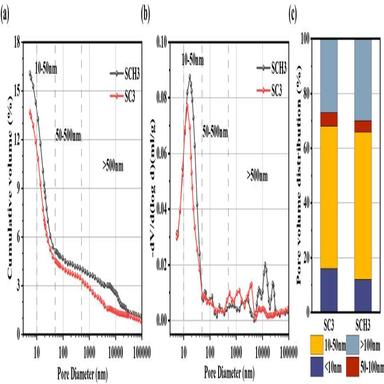
Pore structure by MIP: (a) Pore cumulative volume of SC3 and SCH3; (b) Pore size distribution of SC3 and SCH3; (c) Pore structure of SC3 and SCH3.